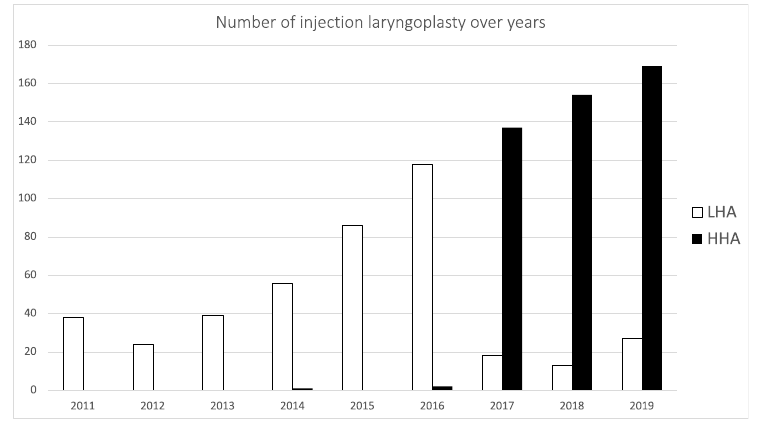
Figure 1. Number of injection laryngoplasties in the two HA groups over years. HHA = high-concentration HA group; LHA = low-concentration HA group.